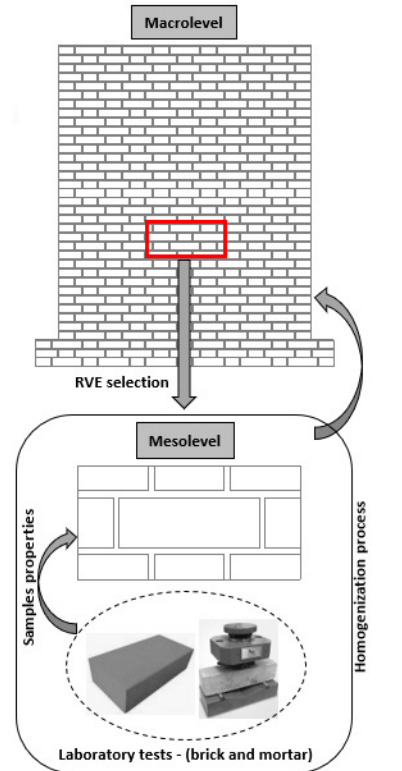
Figure 3. Framework for the homogenization of masonry wall.